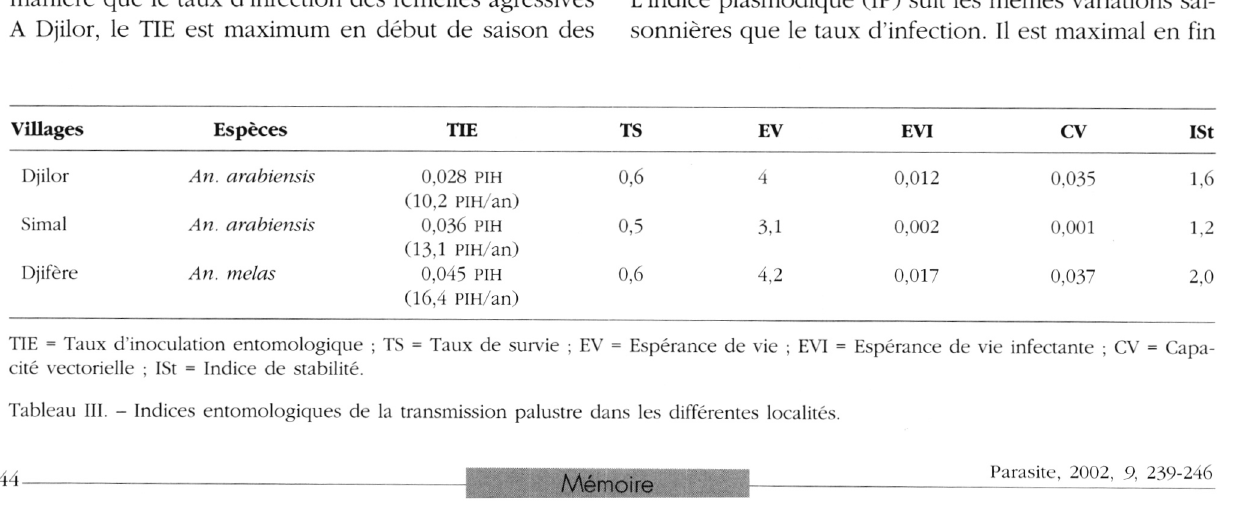
Tableau III. - Indices entomologiques de la transmission palustre dans les différentes localités.